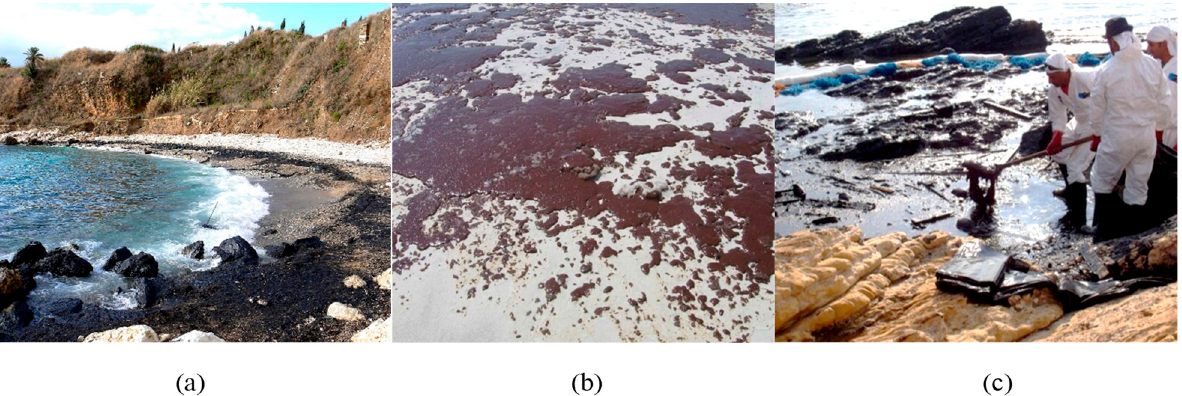
Figure 1. Examples of different forms of oil contamination along with various beaches ( a ) Oil sheet along with tar balls at gravel beach, south beach, Lebanon, ( b ) Gooey mass of spilled oil at sandy beach ( c ) Lebanon rocky beach cleaning of oil spill by workers. (Public domain). Shorelines are exposed to both bulk oils from slicks and dissolved phases in water [37]. The fate of oil reaching a shoreline is dependent on various factors, including the shore’s topography and composition (e.g., rocks, sand, fine or coarse-grained), exposure of the residual oil to waves and tides (low and high), characteristics of the oil (composi- tion, molecular weight, viscosity, solubility) and weather conditions [18]. These character- istics, along with the combination of weathering processes, decide the oil behavior in the context of oil penetration, retention, persistence, remobilization, and translocation (path- way to transport the oil into the environment) [38]. Moreover, transformation is another weathering process that can physically or chemically change stranded oil into other prod- ucts. One of the prominent transformation processes is photo-oxidation which allows ox- ygen to combine with carbon in sunlight to transform the floating slicks into new com- pounds [39]. For instance, during the first few days of the Deepwater Horizon (DWH) oil spill (2010), approximately half of the residual surface oil experienced photo-oxidation and transformed into new partially oxidized chemical compounds [40]. Freeman and Ward [40] found that light sun exposure to the oil could generate water-soluble products, and that was why 3–17% of DWH oil spills dissolved into seawater, the process known as photo-dissolution. Future studies should examine the toxicity risk associated with these UV-induced soluble compounds [38]. Some studies show that photochemistry-based phe- nomena are more effective in a controlled laboratory environment and are not as practi- cable in the natural environment because of the variability of factors (e.g., solar irradiance, UV intensity) [40,41]. Other physical natural attenuation processes are advection, dissolu- tion, emulsification, evaporation, dispersion, and sedimentation [8,42,43]. Particularly in the context of shorelines, Wang et al. [8] discussed that evaporation is the dominant mech- anism in fine-grained and coarse-grained beaches, followed by particle formation and shoreline stranding. In contrast, particle formation is the dominant weathering process in rocky shorelines, followed by evaporation and dissolution [8]. In some conditions, breaking waves on shorelines can mix floating oil with sand or sediments that are suspended in the surf zone to form various sizes of microscopic and macroscopic agglomerates [44]. Macroscopic sediment oil agglomerates (SOAs) range from a few centimeters to several meters, formed by the interaction between mousse and fine or coarse sediments [45]. The sediment-oil mat (SOM) is formed if the agglomerate size is more than one meter in length [45,46]. Michel and Bambach [47] classified SOM as oily (>40% oil) and sandy (<40% of oil), where oily SOMs can separate oil from the sand and refloat. Both SOAs and SOM can persist in a nearshore ecosystem for years after a spill incident [45]. For example, after five years of the Macondo incident (deep horizon rig oil spill) in the Gulf of Mexico, SOAs and SOM have been found on Alabama’s beach [23]. Whereas microscopic oil particle aggregates (OPAs) formed when fine sediments interact